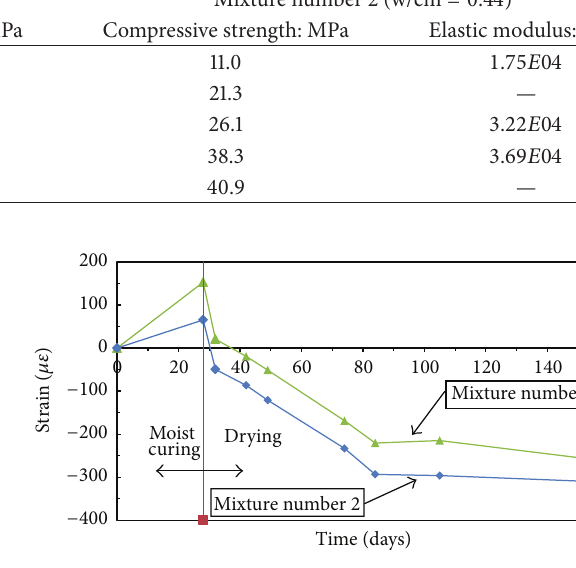
Figure 2: Drying shrinkage strain development over time for Mixture number 1 and Mixture number